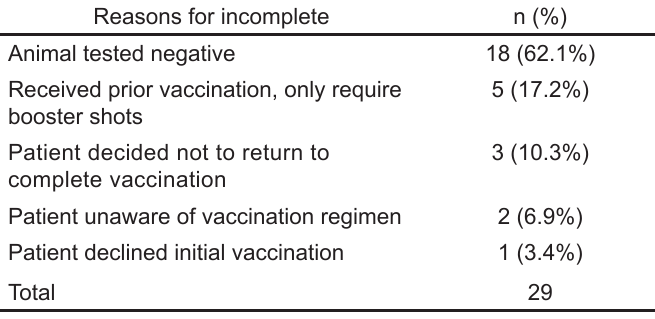
Table 2. Reasons for incompletion of vaccination regimen.